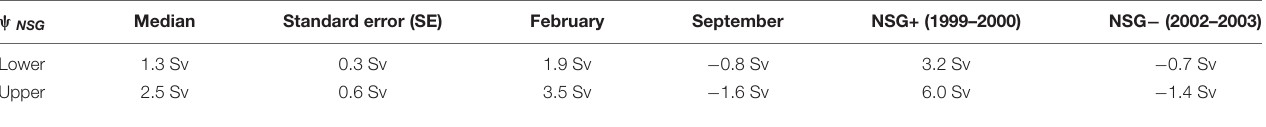
TABLE 3 | Statistics of the NSG rim transport ( ψ NSG ), provided as a lower estimate (width W = 30 km and average depth D = 2 km, see eq. 4) and as an upper estimate ( W = 30 km and average depth D = 2.5 km). ψ